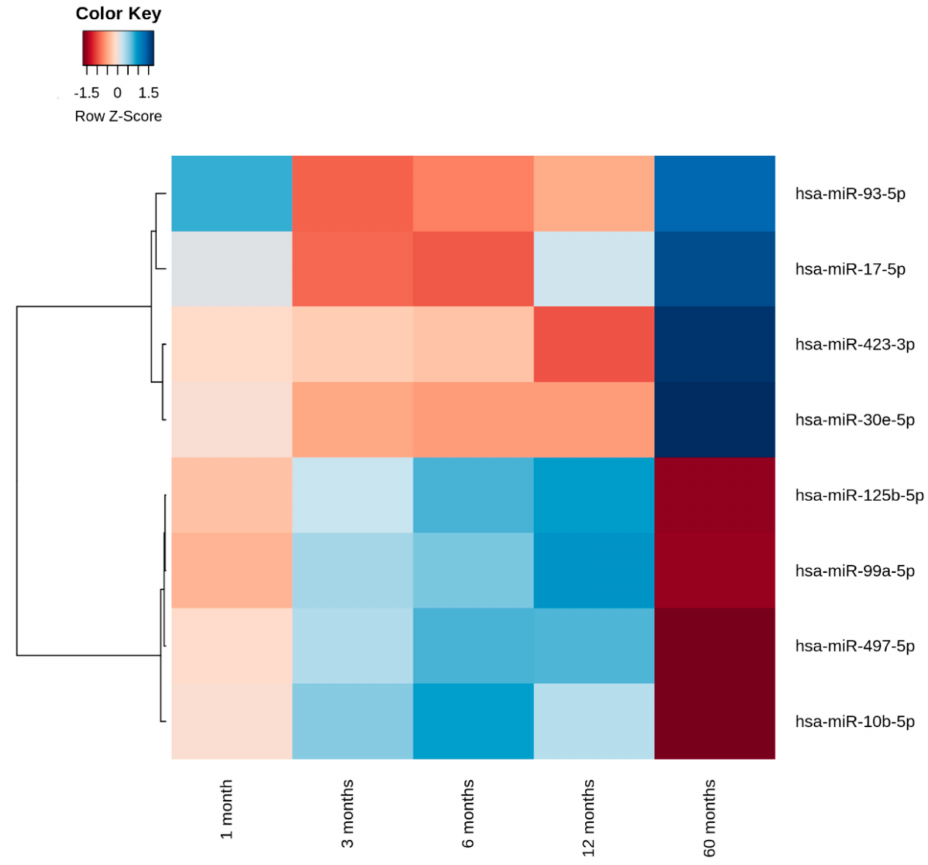
Figure 1. The eight candidate microRNAs (miRNAs) with changing expression levels during the first five years after diagnosis. The normalized expression ( ∆ Cp) values of the miRNAs at different time-points are clustered based on the distance measure (which is calculated as 1-cor) and transformed into Z-scores. cor = Pearson’s correlation